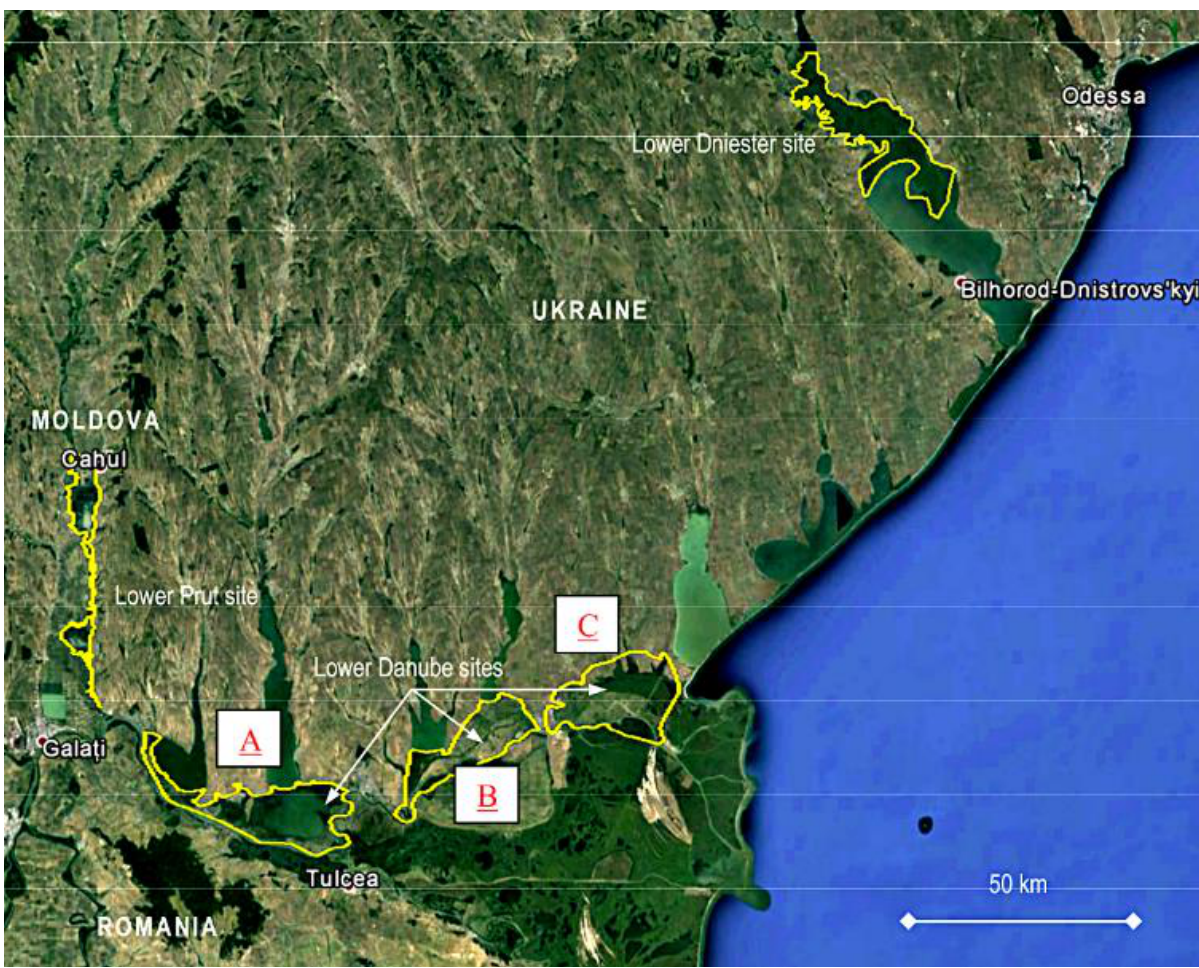
Figure 1. Location of the ReedBASE study sites: the Lower Prut floodplain in Moldova, from Cahul to Giurgiulesti (top left); three sections of the Lower Danube floodplain between Reni and Vylkove in Ukraine (A) from Reni to Izmail, (B) from Izmail to Kiliya and (C) from Kiliya to Vylkove and Primorsky; and the lower reaches of the Dniester/Turunchuk rivers in Ukraine, from the border with Moldova to their entry into the coastal Dniester Liman (top right). Source: ReedBASE